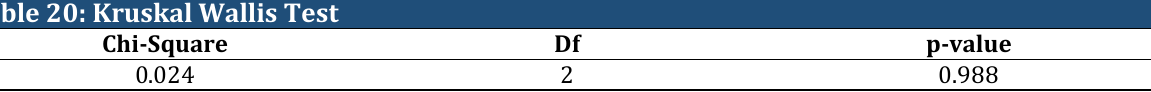
Table 20: Kruskal Wallis